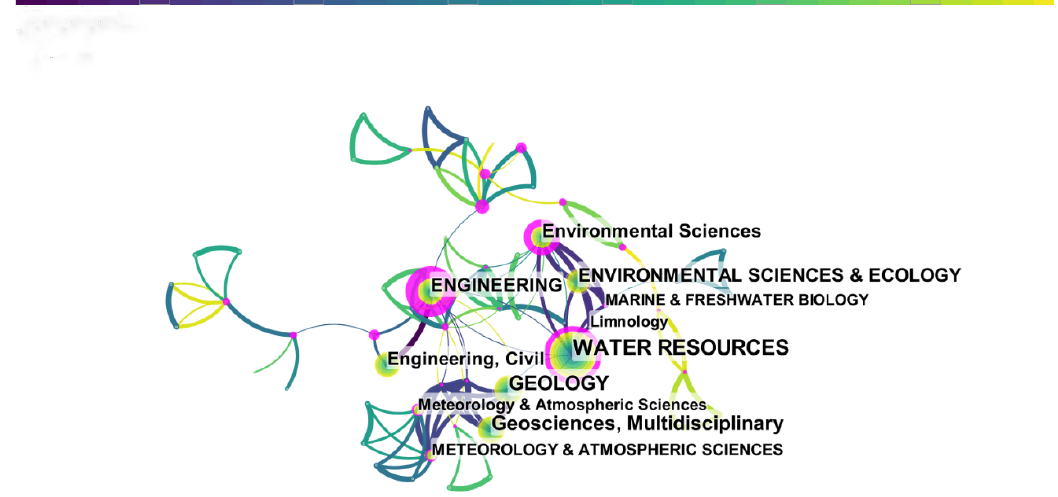
Figure 5. Disciplines co-occurrence network map involving distributed hydrological models.